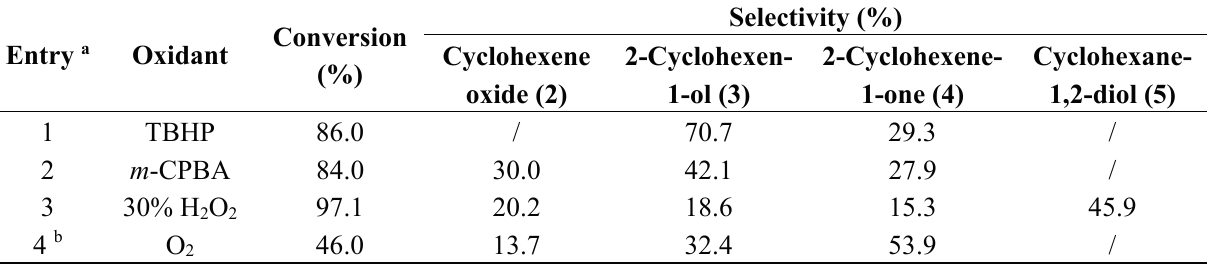
Table 2. The selective oxidation of cyclohexene to 1,2-diols catalyzed by iron (III) phthalocyanines with triflate as a counter anion and different oxidants.